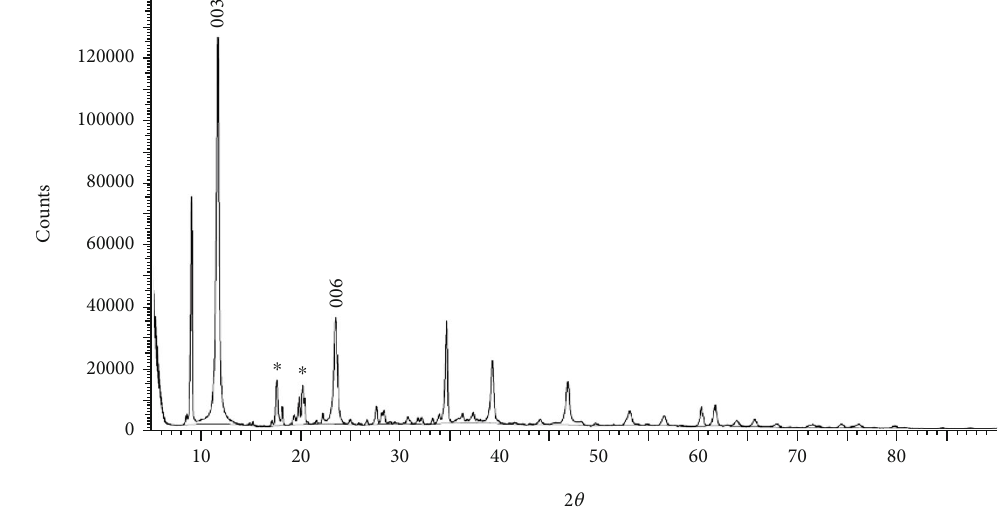
Figure 7: Di ff ractogram obtained for BTZ-LDH.